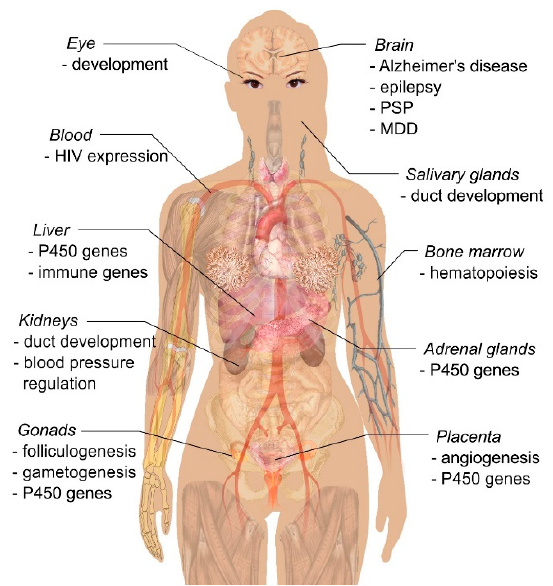
Figure 1. Functions of TFCP2 (transcription factor cellular promoter 2), TFCP2L1 (TFCP2-like 1), and UBP1 (upstream binding protein 1) in various organs. The only proven disease links or targets of regulation are shown. Note that, although TFCP2 and UBP1 are expressed ubiquitously, their role in most tissue and organs remains unknown. The functions of these factors in the liver, bone marrow, eye development, and regulation of HIV expression were summarized in an earlier review [3], therefore we do not discuss them here. Background image source: Wikimedia Commons.